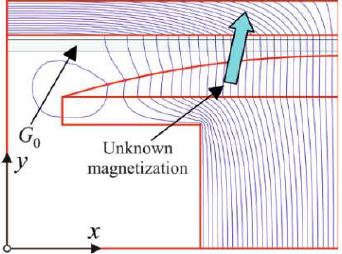
Figure 8. The magnetic pole of a PM-excited SM with location-dependent